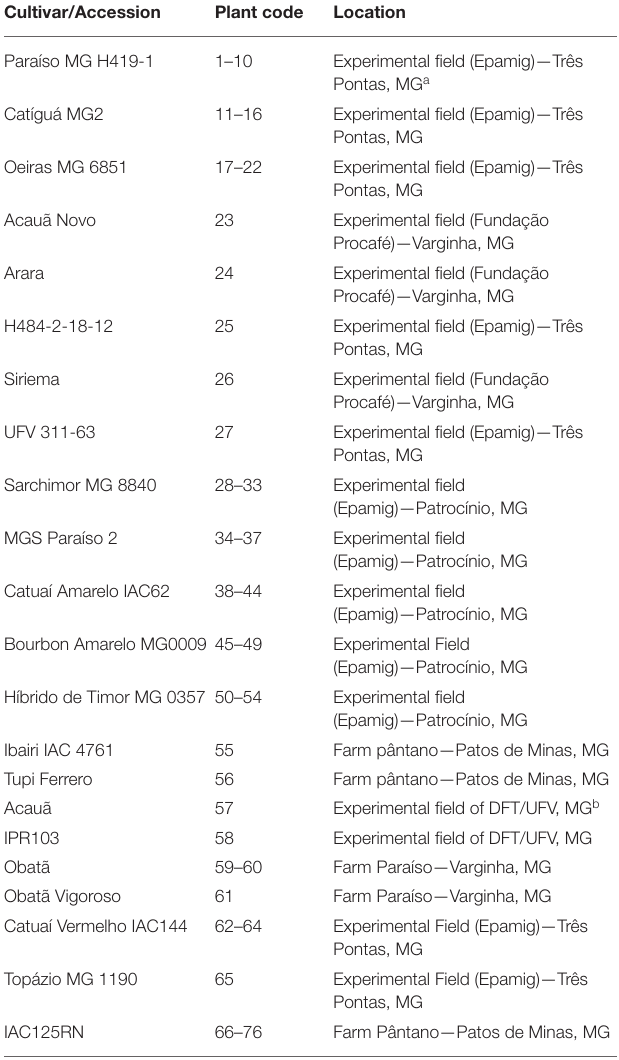
TABLE 1 | Coffee cultivars and accessions used in the genetic diversity analysis. Cultivar/Accession Plant code